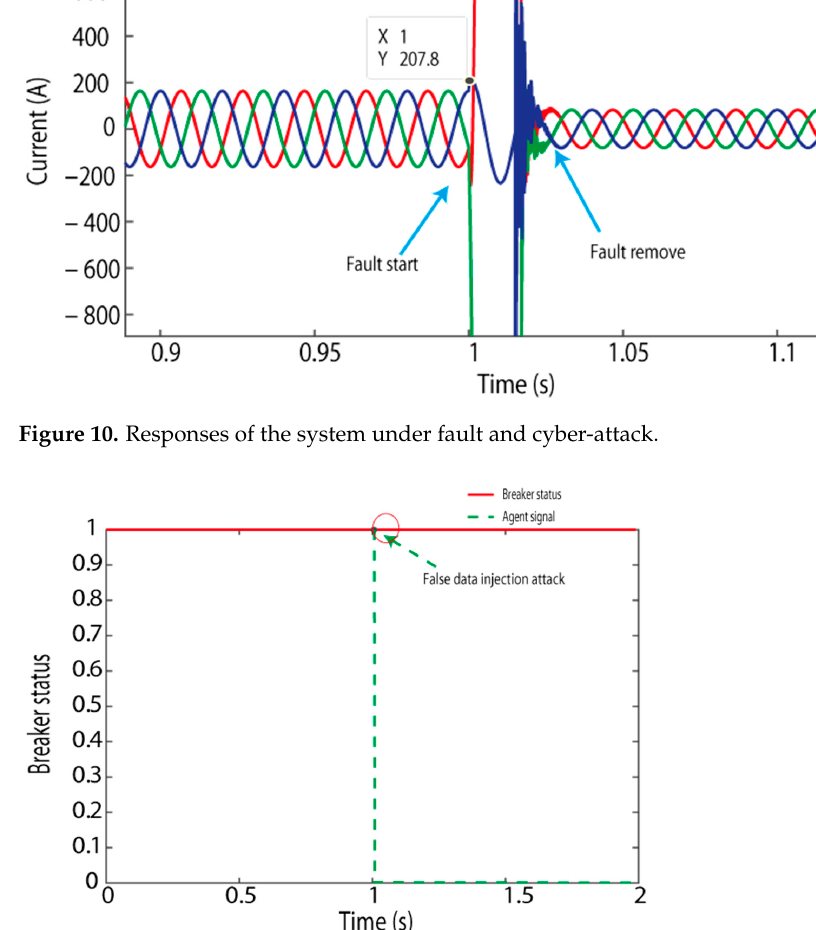
Figure 11. Breaker status for CB5 during Double-line-to-ground fault.